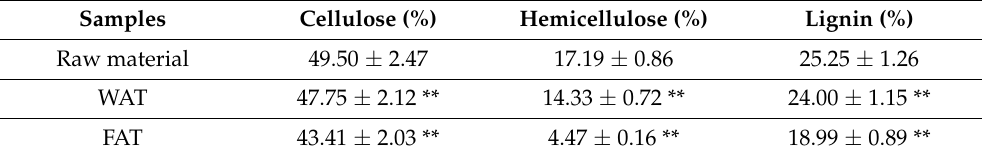
Table 3. Chemical composition of bamboo after different